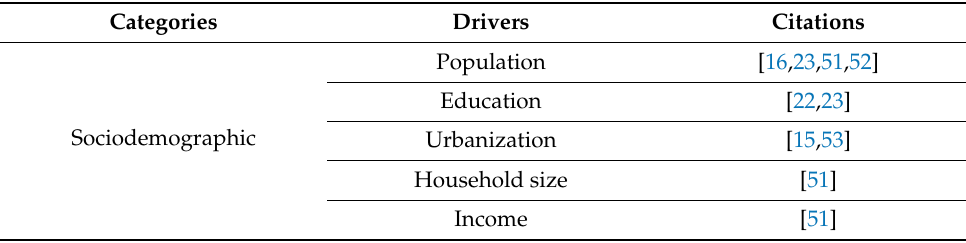
Table 1. Sources of publications for water use driver